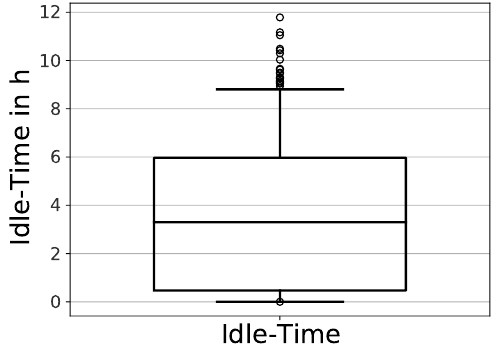
Figure 6. Idle time for the office site.